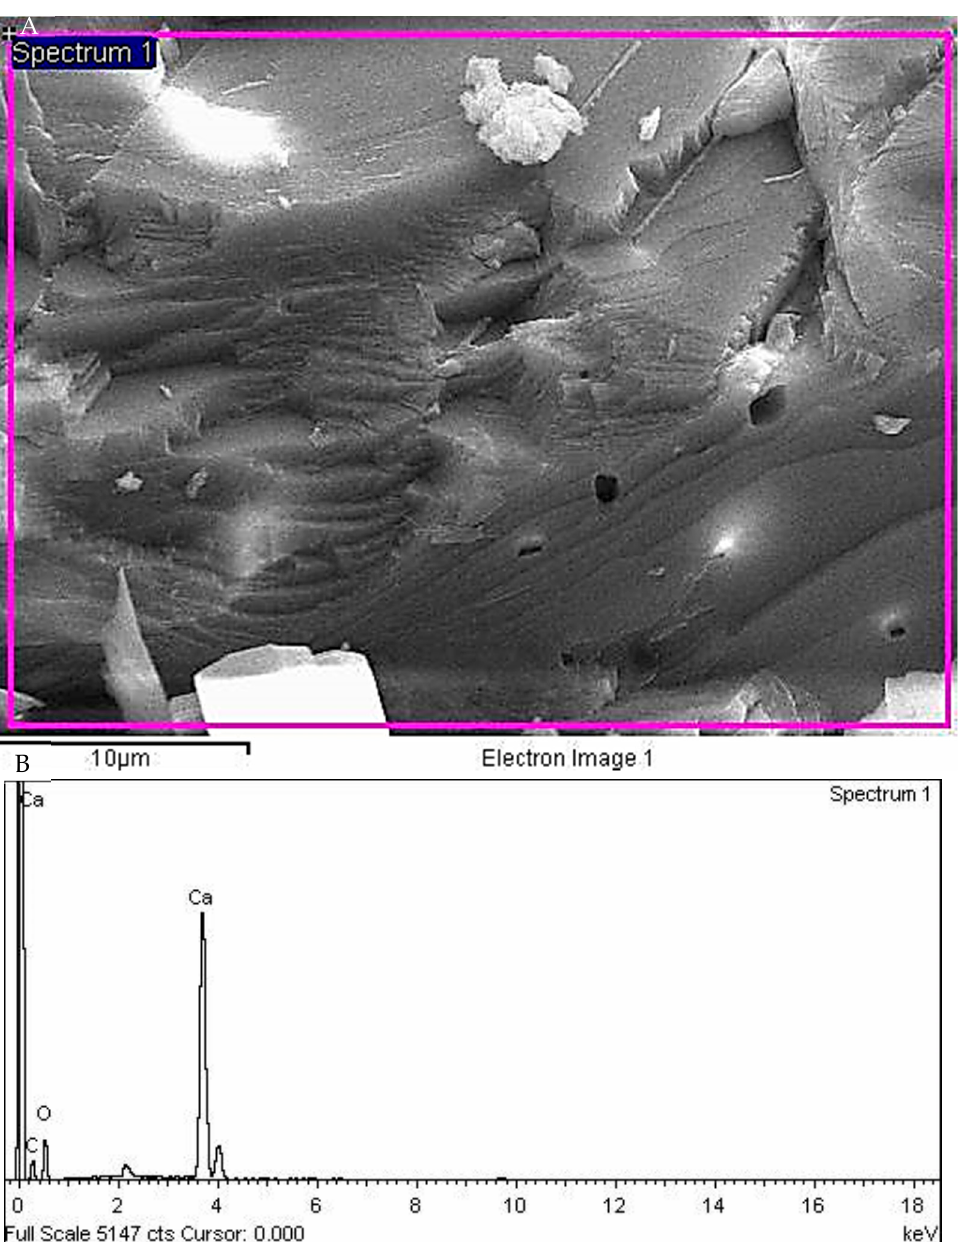
Figure 9. ( A ) FESEM image and ( B ) EDX spectrum of Segamat basalt sample. Elemental analysis by the EDX shows that C (7.99 wt.%), O (45.51 wt.%), and Ca (46.50 wt.%) are the main elements.